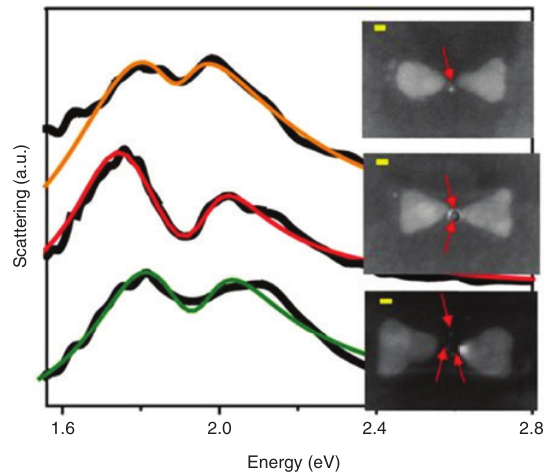
Figure 21: Experimentally obtained strong coupling between silver nanobowtie structures and one, two, or three CdSe/ZnS QDs located in the gap of the bowtie structure. Black lines represent experimental scattering measurements and colored lines are fits. SEM images show corresponding structures.